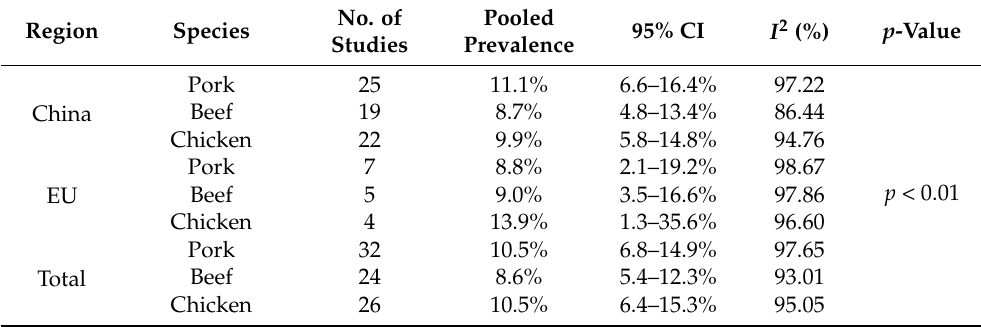
Table 5. Subgroup analysis of the prevalence of L. monocytogenes among pork, beef and chicken. No. of Region Species